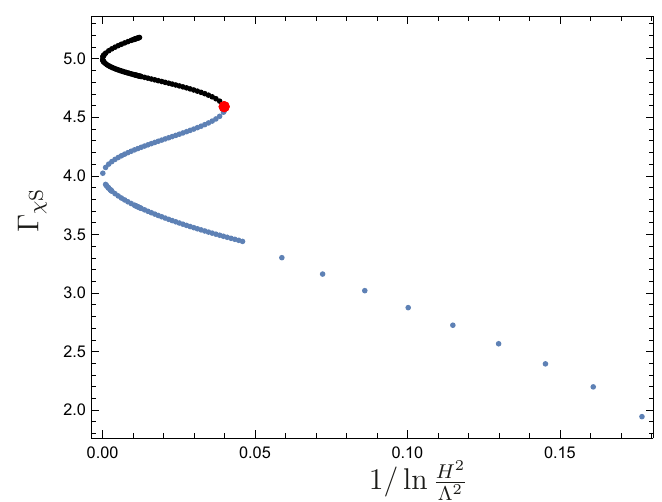
Figure 9 . Sub-branches of the distinct in the conformal limit branches of the fluctuations coalesce as is lowered. The red dot, see (4.9), highlights this phenomenon for n = 5 and n = 4 H Λ